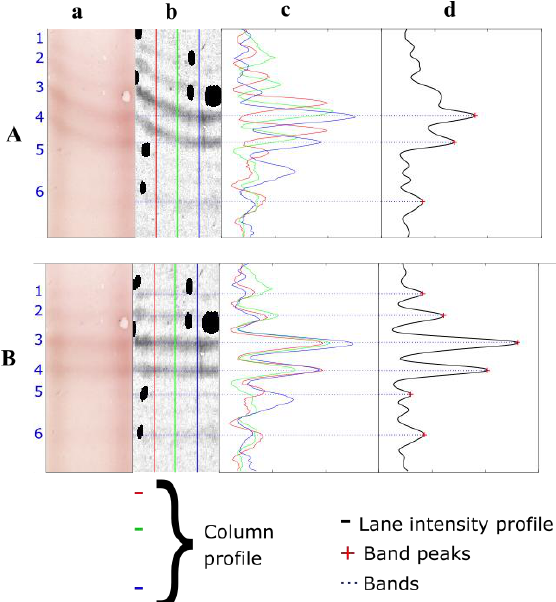
Figure 2. Illustration of the importance of band straightening for faint, non-horizontal bands in a CSF lane: ( Aa ): a lane with deformed bands; ( Ba ): the same lane with straight bands; ( Ab , Bb ): a background-subtracted grayscale image (contrast ×12, for clarity); ( Ac , Bc ): three column profiles with and without band deformations, band peaks and signal valleys are aligned in ( Bc ); ( Ad , Bd ):